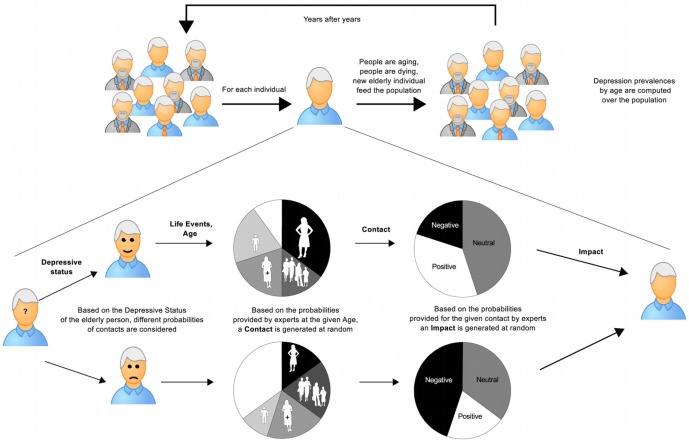
Schematic algorithm.A population is simulated where each individual elderly person is processed. Elderly depression dynamics are influenced by late-life events, social support and personal depressive status, and this influence is quantified by experts' opinions. Each year some elderly people die and new ones are integrated in the population.